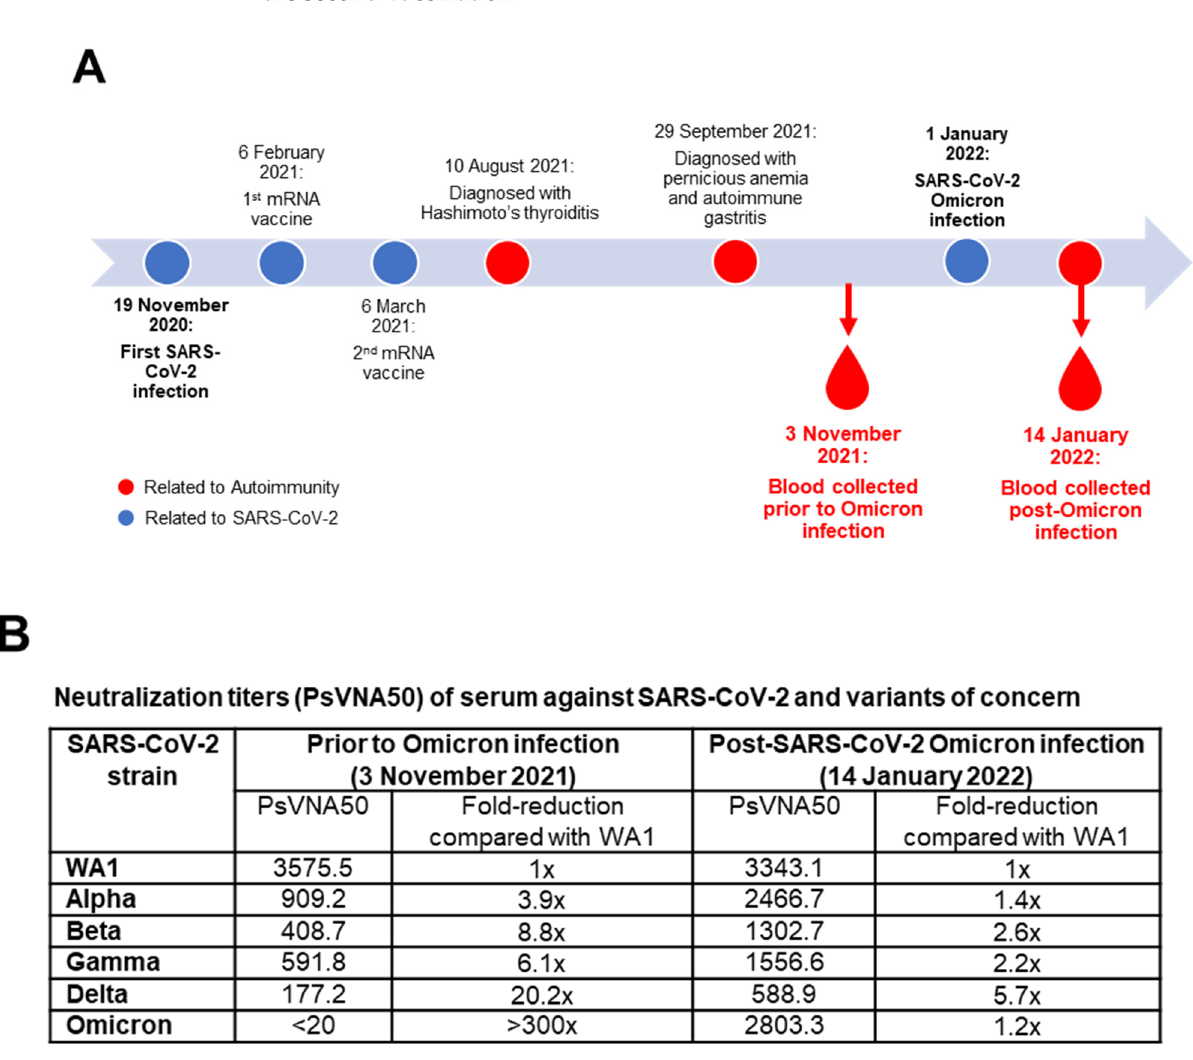
Figure 1. Effect of SARS ‐ CoV ‐ 2 vaccination induced immune response and breakthrough Omicron infection in autoimmune patient. ( A ) Timeline of SARS ‐ CoV ‐ 2 infections, mRNA vaccinations, and autoimmune diagnosis in relation to Omicron re ‐ infection. ( B ) SARS ‐ CoV ‐ 2 neutralizing antibody titers as determined by pseudovirus neutralization assay in 293 ‐ ACE2 ‐ TMPRSS2 cells with SARS ‐ CoV ‐ 2 vaccine homologous WA1/2020 strain, and variants of concern (VOCs): Alpha, Beta, Gamma, Delta, and Omicron in a SARS ‐ CoV ‐ 2 PsVNA. PsVNA50 (50% neutralization titer) titer values are shown two months before and 14 days after Omicron infection. Fold reduction (i.e., reduction in neutralization titer) in PsVNA50 titers for each VOC, compared with the prototype WA1/2020 vaccine strain, is shown in the right columns.